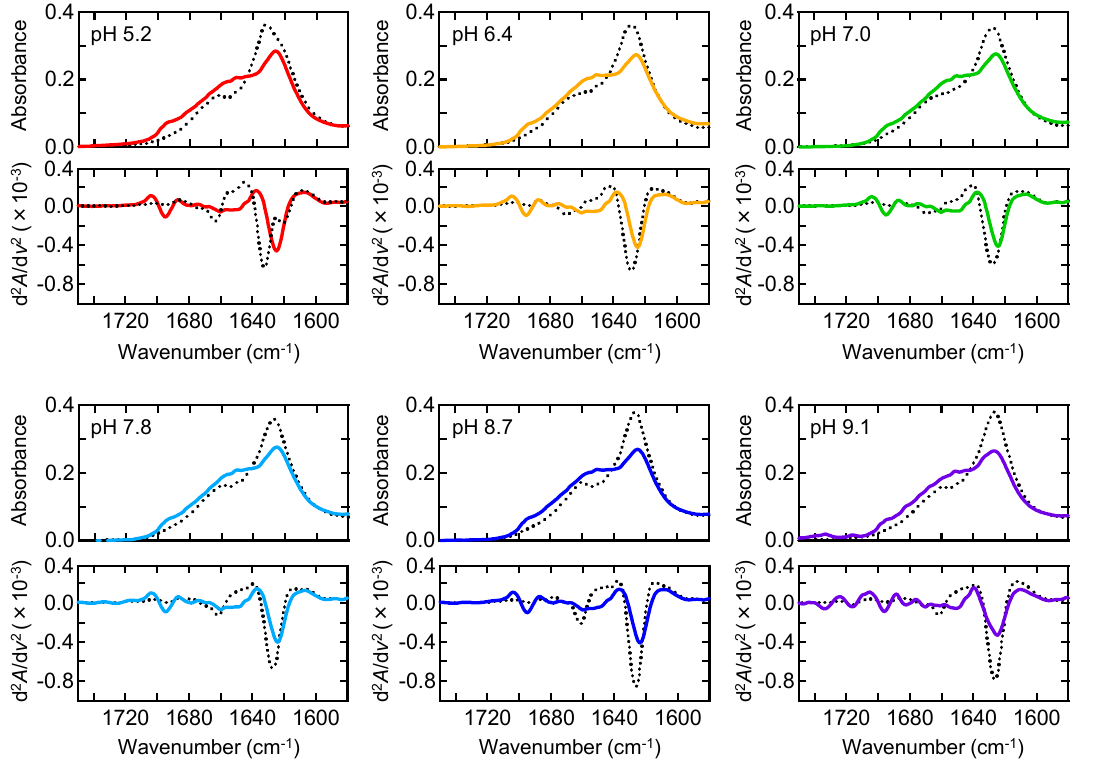
Figure 2. Structural properties of nonfibrillar aggregates formed under quiescent conditions at various pHs. ATR-FTIR absorption spectra and their second derivatives are shown in upper and lower panels, respectively. Solid lines indicate the spectra of nonfibrillar aggregates formed under quiescent conditions, and the spectra of amyloid fibrils formed under agitated conditions are also represented by black dotted lines. Spectra were normalized so that the integrated intensity of the amide I band ranging from 1580 to 1750 cm − 1 was set to be equal.